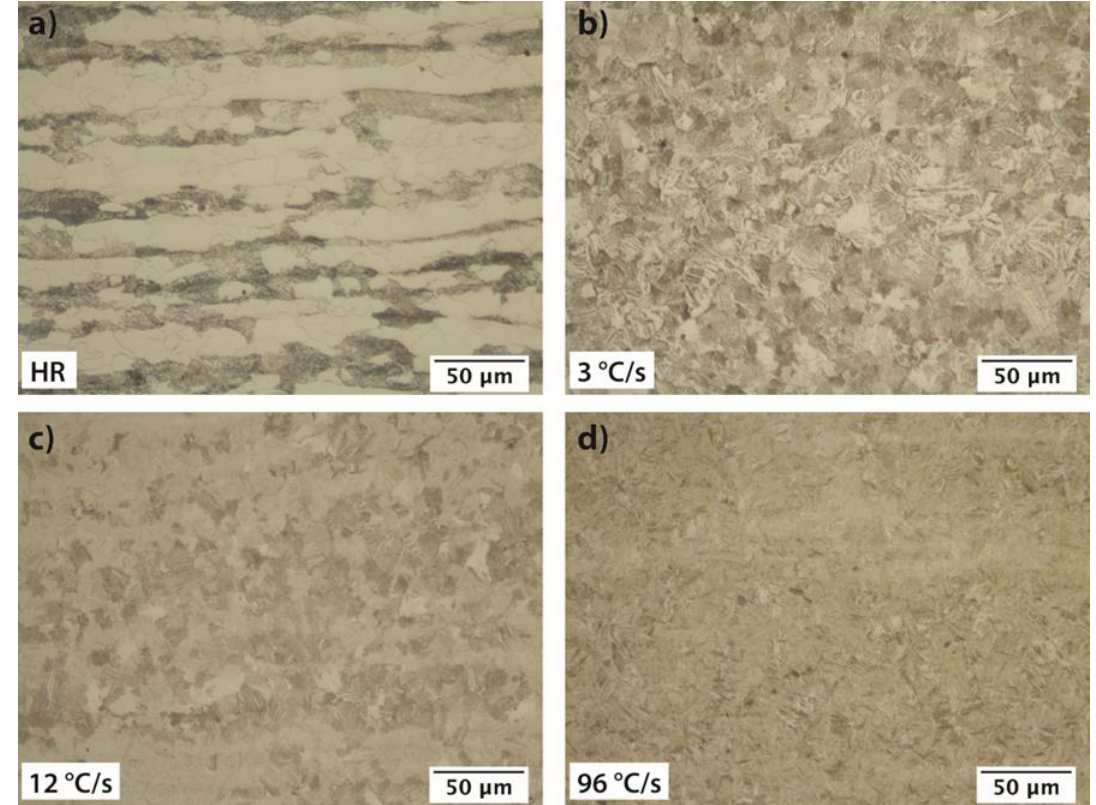
Figure 2. Optical micrographs of the hot-rolled (HR) microstructure and Gleeble samples with different cooling rates: ( a ) hot-rolled, ( b ) 3 °C /s, ( c ) 12 °C/s, ( d ) 96 °C/s.